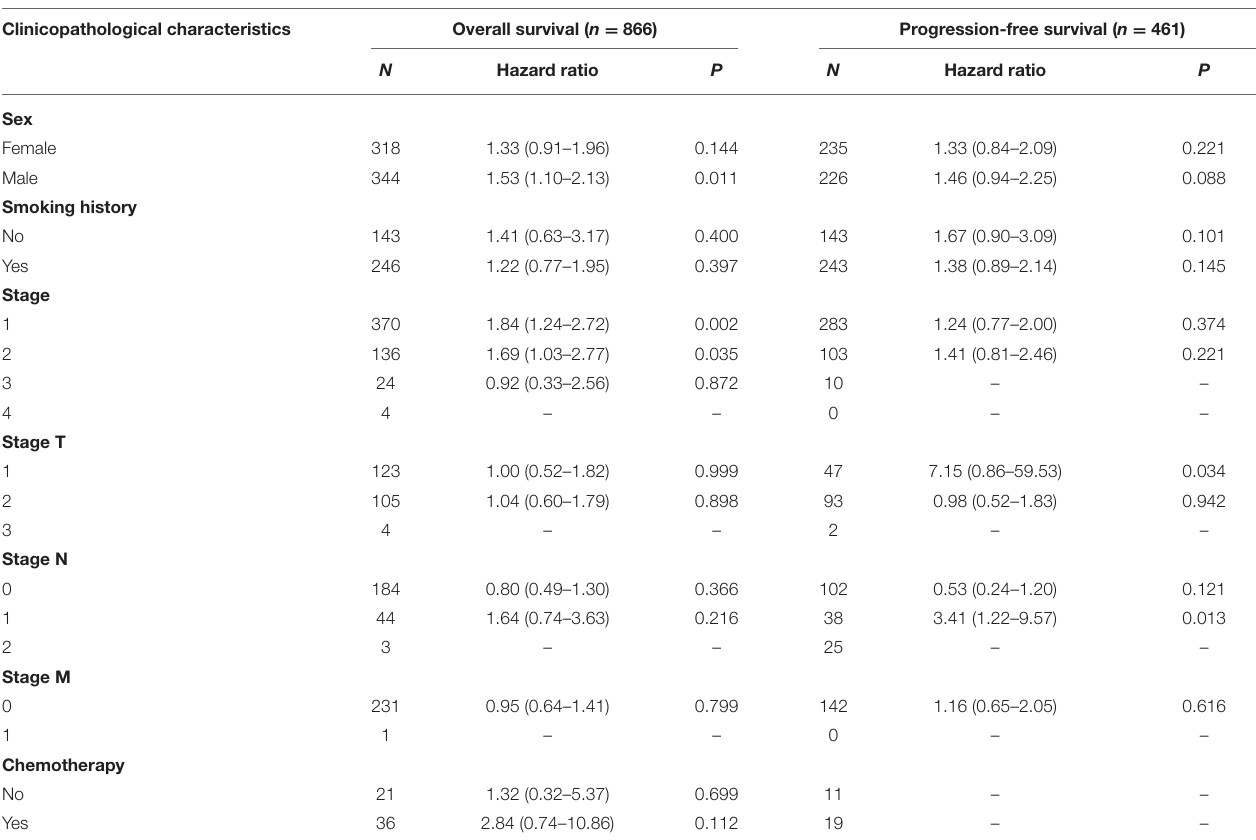
TABLE 2 | Correlation of TIM1 mRNA expression and clinical prognosis in lung adenocarcinoma with different clinicopathological factors by Kaplan-Meier plotter (GSE29013, GSE31210, GSE31908, GSE43580, GSE50081, GSE8894). Clinicopathological